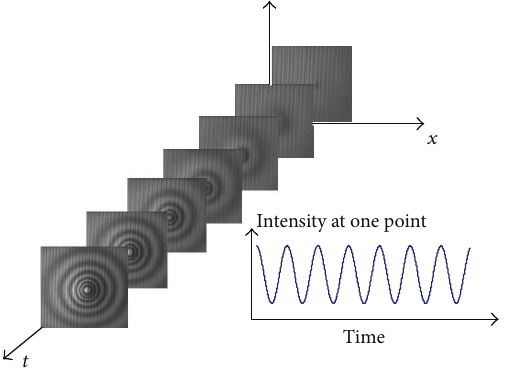
Figure 2: Schematic layout of the high-speed-imaging-based IDM.